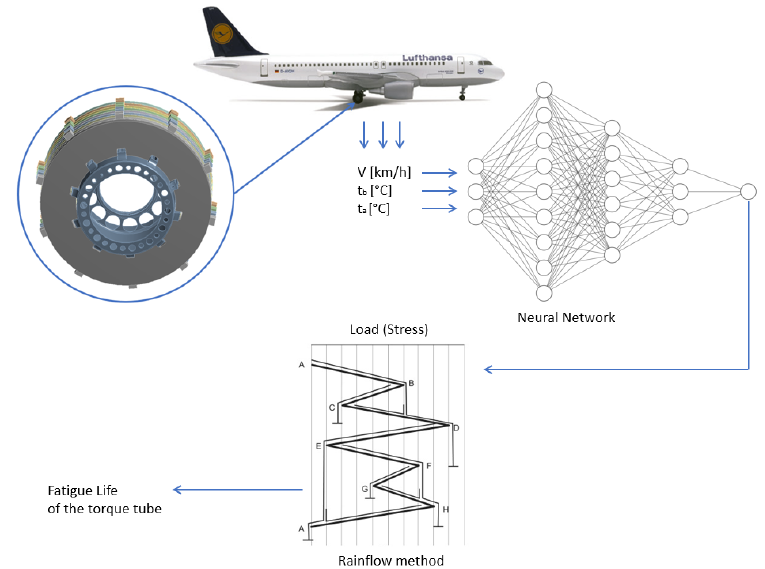
Figure 13. Methodology for aircraft-torque-tube-life prediction based on the numerical methods.